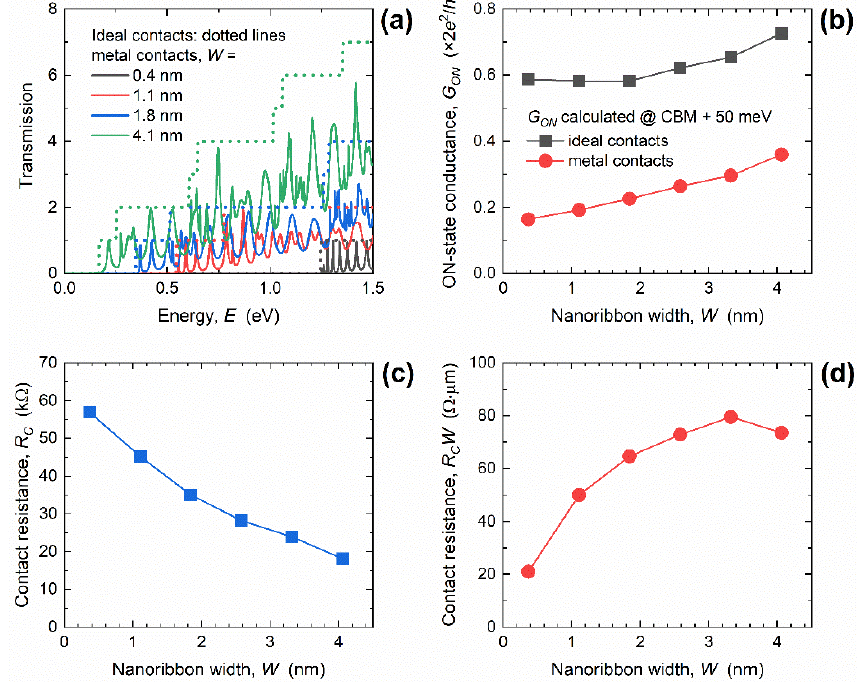
Figure 3. ( a ) Width-dependent transmission in GNRs with ICs and MCs. Impact of GNR width downscaling on ( b ) ON-state conductance, ( c ) contact resistance, and ( d ) width-normalized contact resistance. In all cases, L = 15.2 nm.